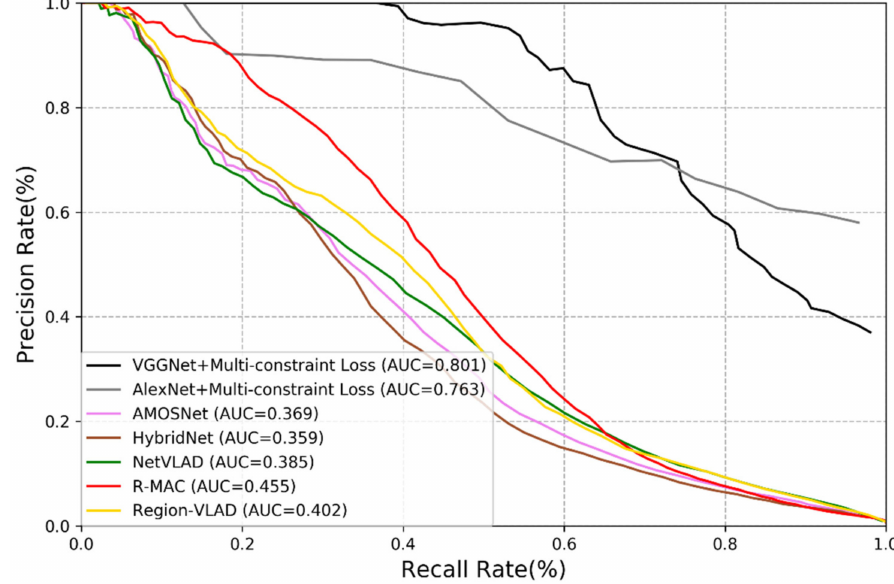
Figure 5. Precision-recall curve of different methods on the New College dataset.